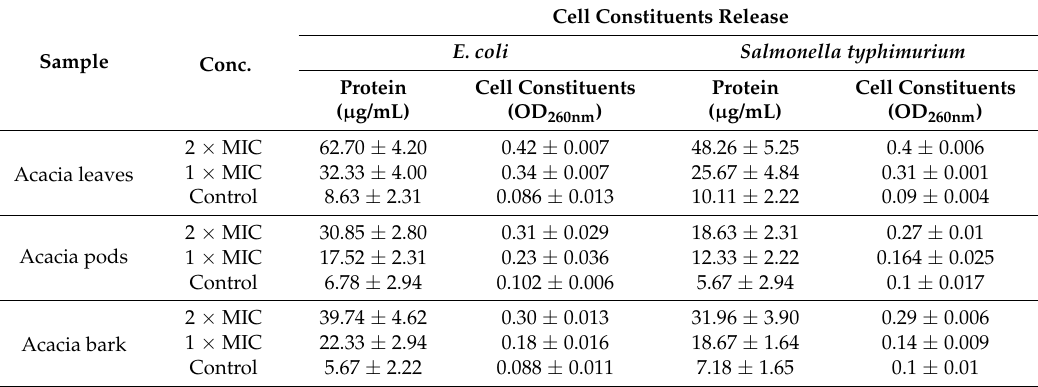
Table 4. Effects of acacia leaves, pods and bark extracts on cell constituents’ release of tested E. coli and Salmonella typhimurium